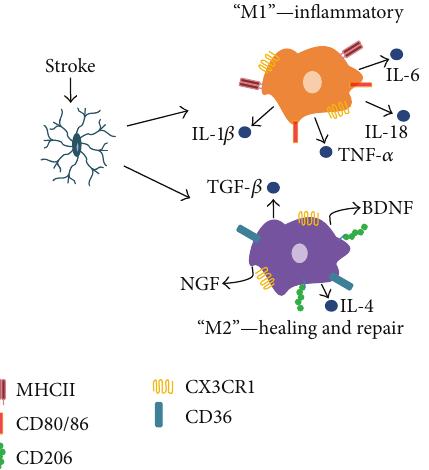
Figure 1: Microglia polarization is characterized by distinct pheno-